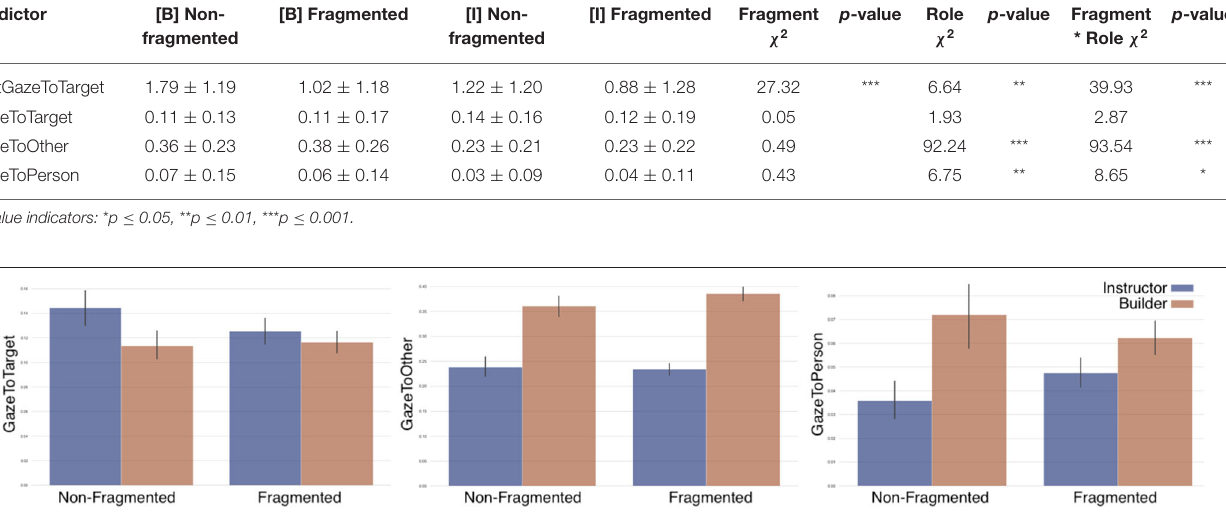
FIGURE 6 | Differences in eye-gaze measures among fragmented and non-fragmented instructions: (A) Proportional gaze to target object, (B) Proportional gaze to other objects, and (C) Proportional gaze to person. Error bars indicate the standard errors of the means.